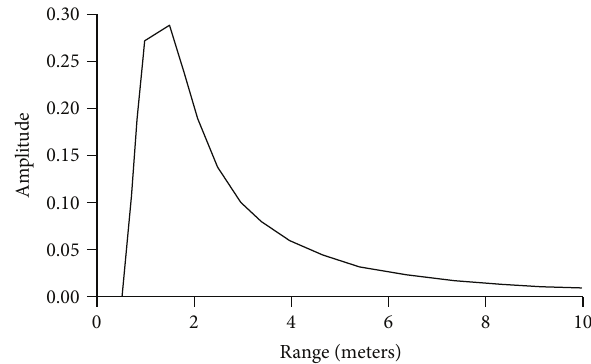
Figure 9: Fraction of transmitted signal on receiver detectors versus